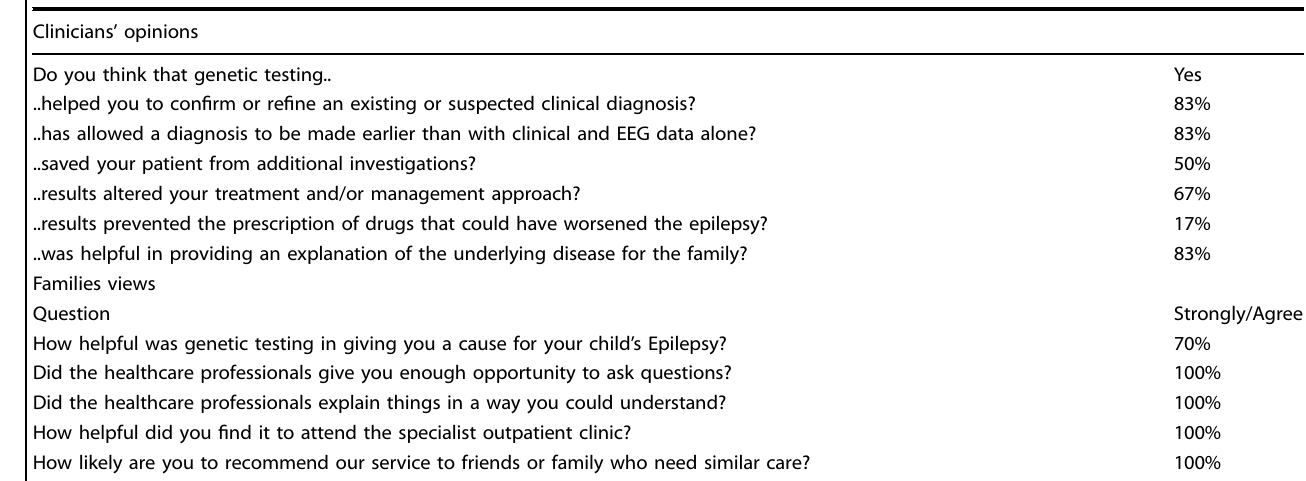
Table 5. Referring clinicians ’ opinions and families ’ views of the epilepsy genetics service Clinicians ’ opinions Do you think that genetic